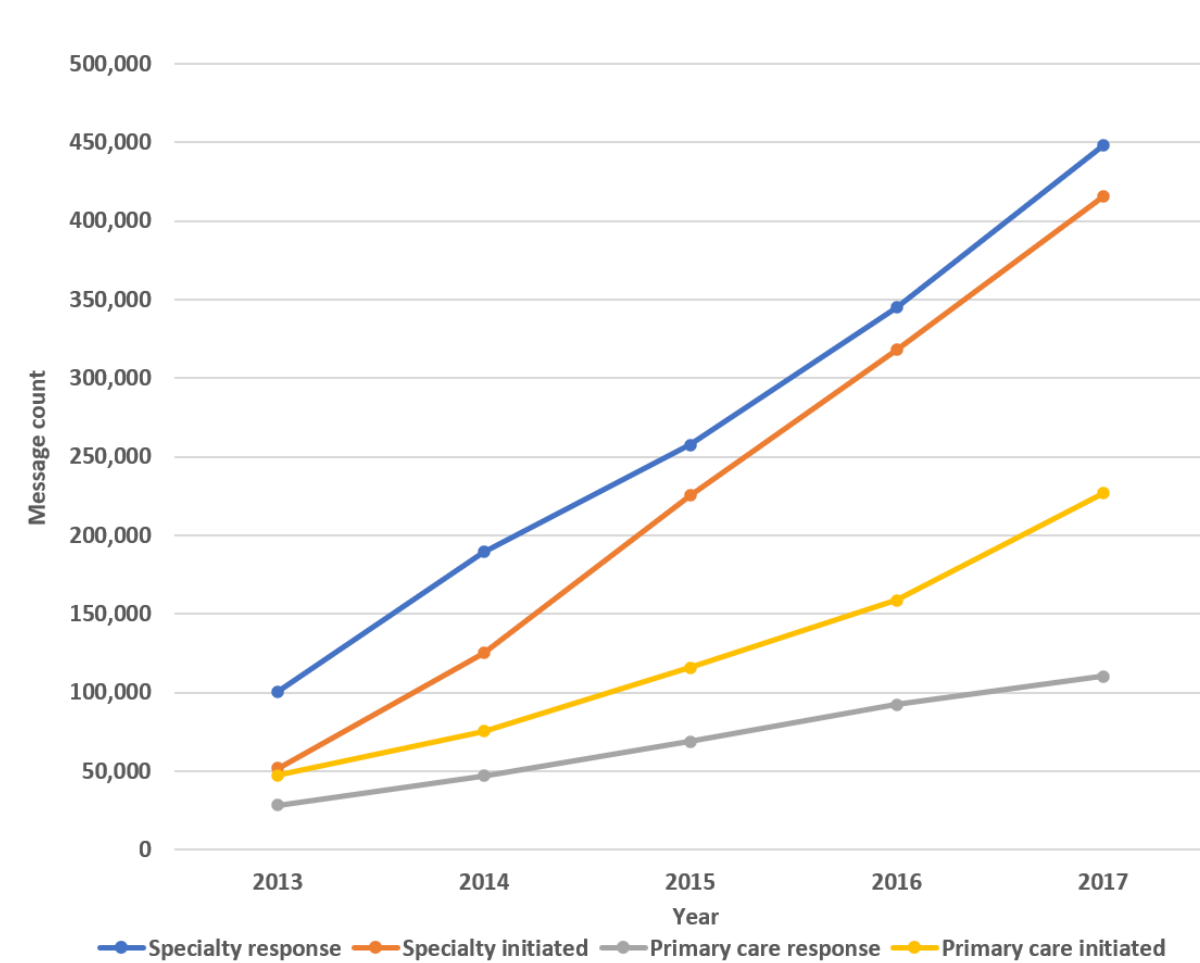
Figure 1. Message counts by